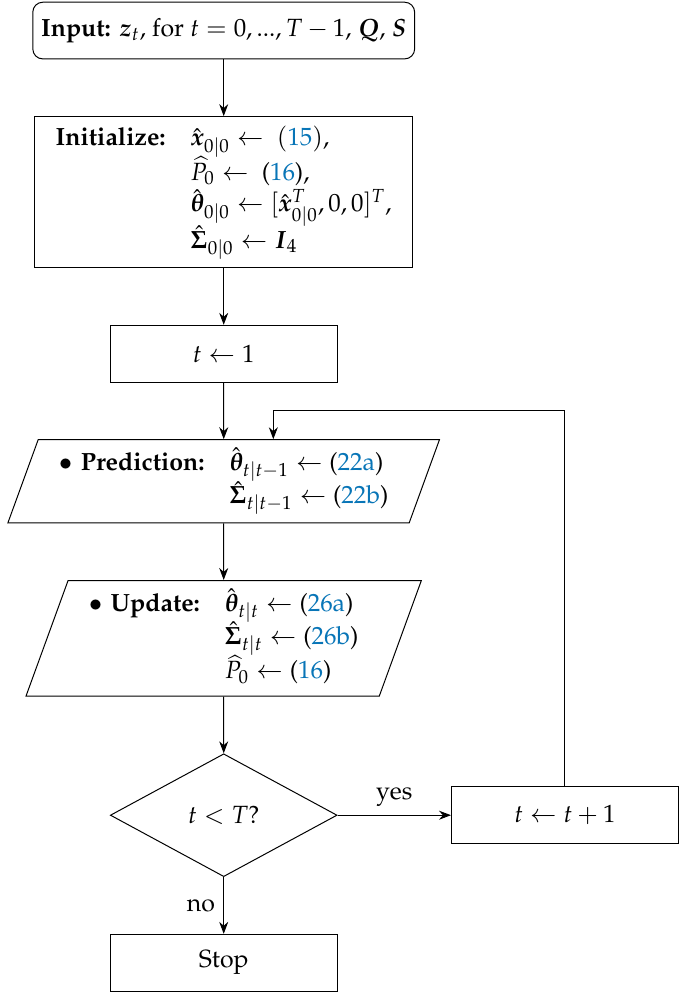
Figure 2. Flowchart of the proposed uKF